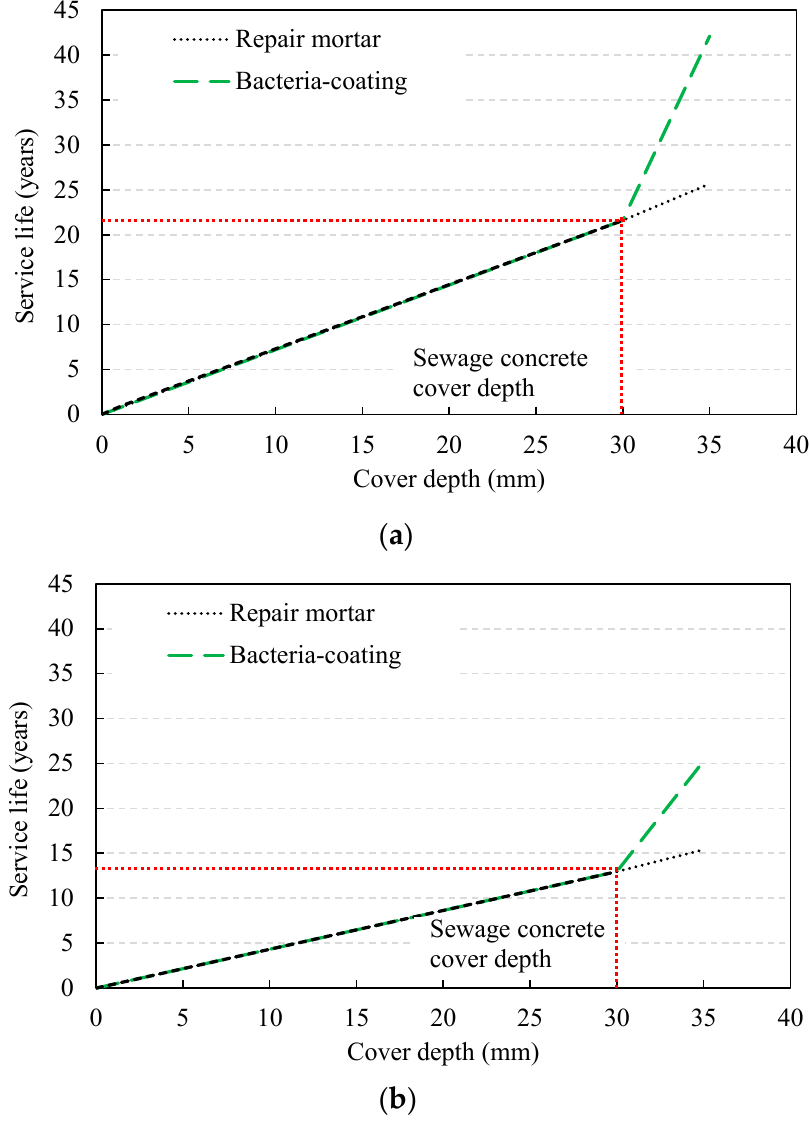
Figure 14. Service life variation according to deterministic method: ( a ) sulfate concentration = 120 ppm; ( b ) sulfate concentration = 200 ppm.